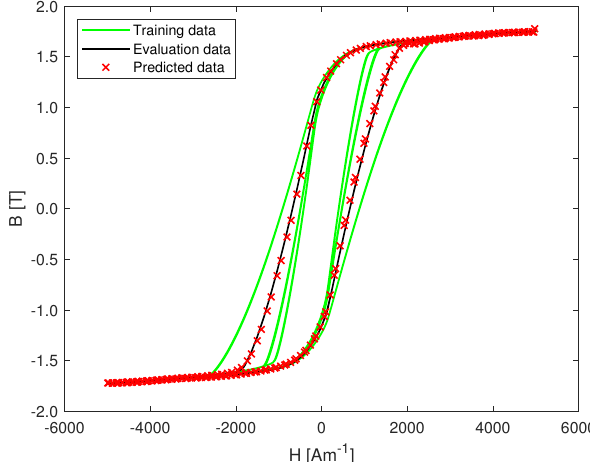
Figure 8. Predicted major loop and experimental data used in training the